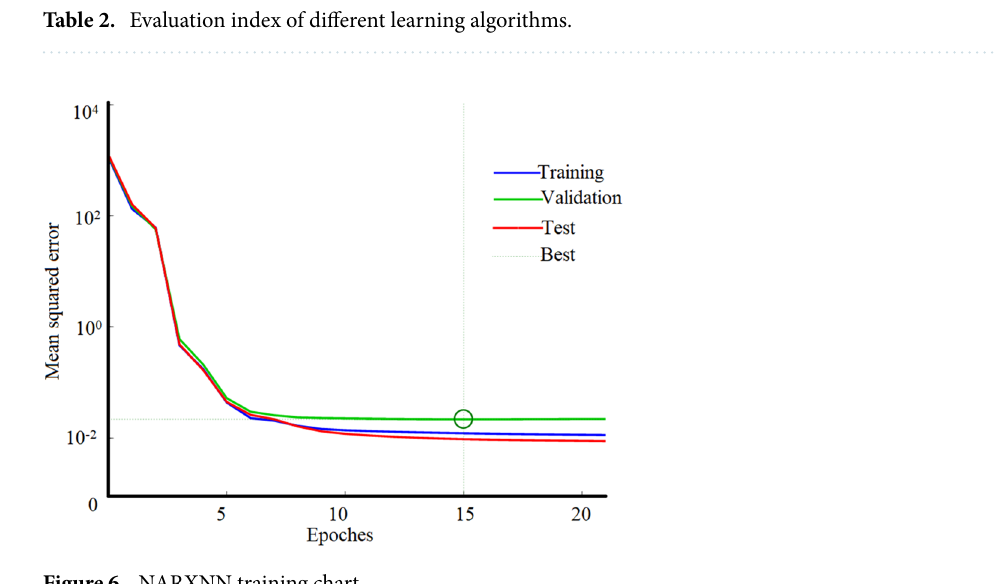
Figure 6. NARXNN training